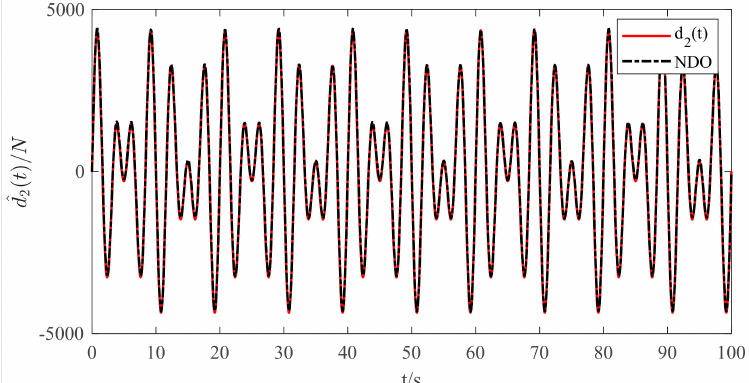
Figure 7. Hydraulic compensation system boundary disturbance force.